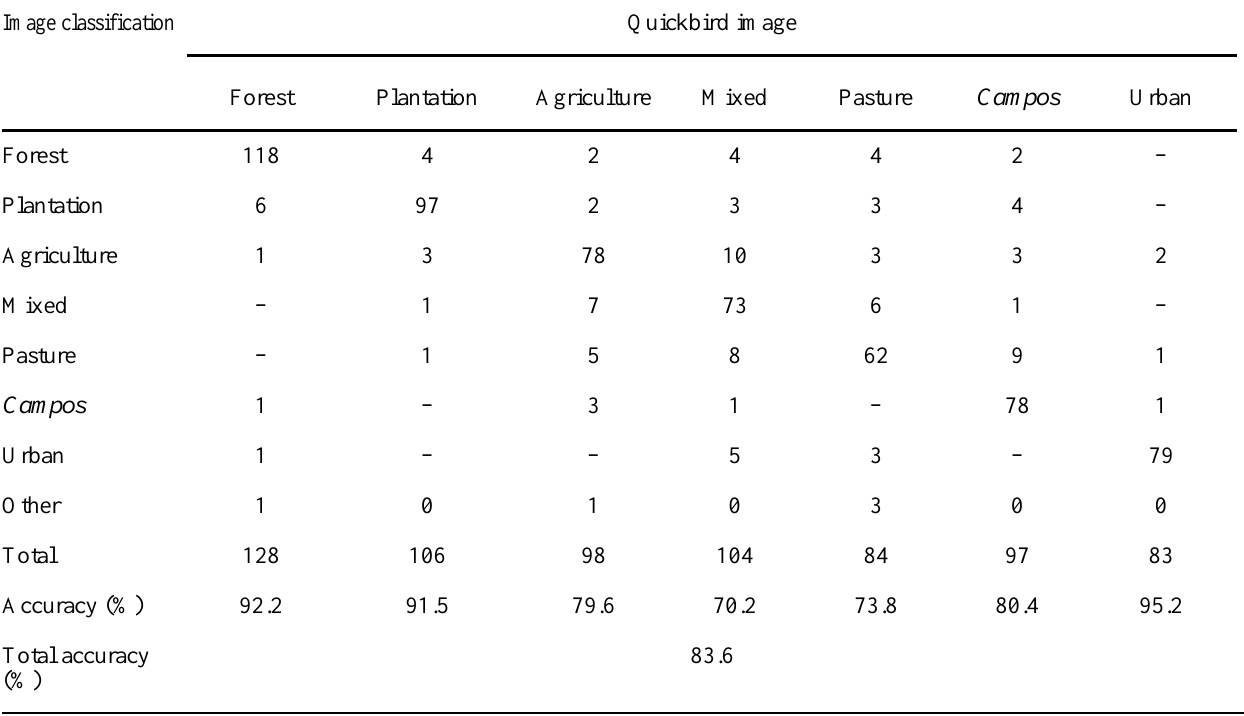
Table 2. Assessment of the accuracy of the land-use classification for 2006 by verification using Quickbird images from